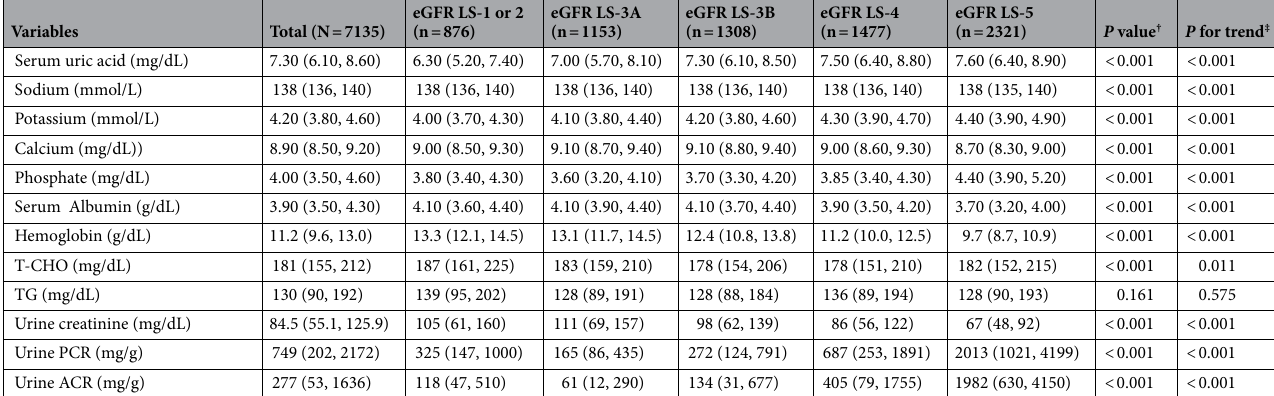
Table 1. Baseline demographic and clinical characteristics according to eGFR LS defined by using GBTM. ACEIs angiotensin-converting-enzyme in inhibitors, ACR albumin/creatinine ratio, ARBs angiotensin receptor blockers, BMI body mass index, CCB calcium channel blocker, CKD chronic kidney disease, eGFR estimated glomerular filtration rate, GBTM group-based trajectory modelling, IQR inter-quartile range, NSAID nonsteroidal anti-inflammatory drugs OAD oral antidiabetic, PCR protein/creatinine ratio, T-CHO total cholesterol, TG triglyceride. † p values are calculated by Kruskal–Wallis test for continuous variables and Chi- square test for categorical variables. ‡ p values for trend are calculated by Spearman’s correlation for continuous variables and by Cochran-Armitage trend test for binary variables.